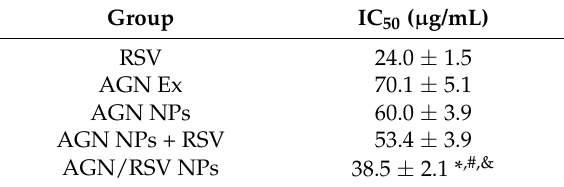
Table 2. IC 50 values of RSV, AGN Ex, AGN NPs, AGN NPs + RSV, and AGN/RSV NPs in SKOV-3